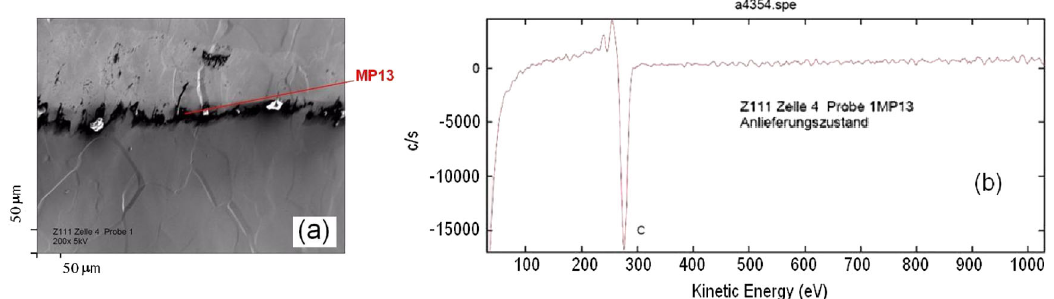
FIG. 6. (a) Area of black spots detected in the cavity Z111; (b) Auger spectrum of the black spots of (a) indicating the presence of